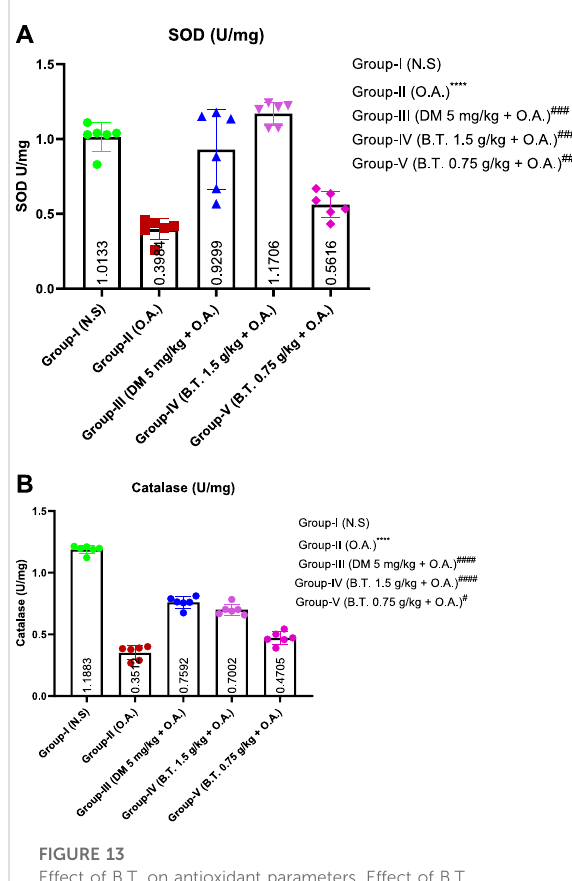
FIGURE 13 Effect of B.T. on antioxidant parameters. Effect of B.T.